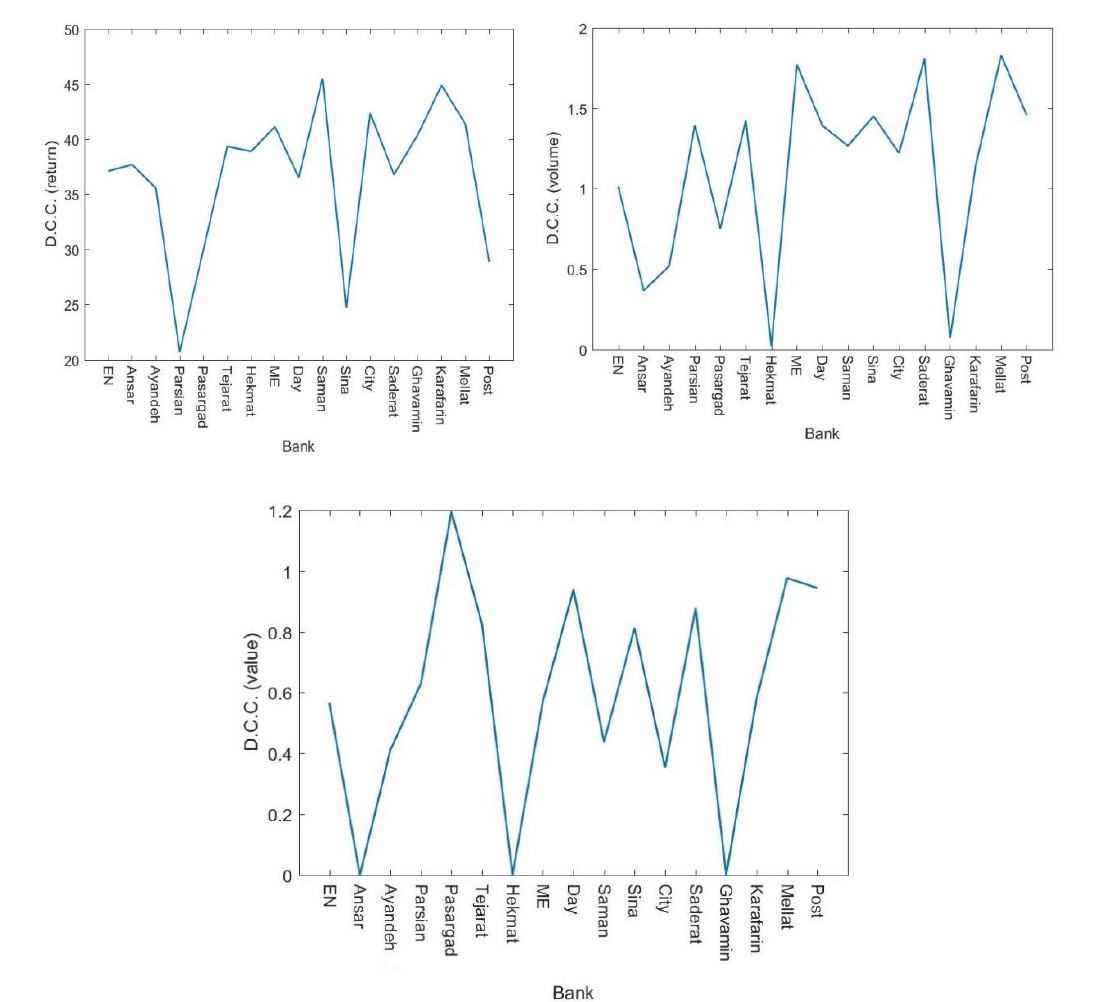
Figure 6.Clustering coefficients of nodes in different